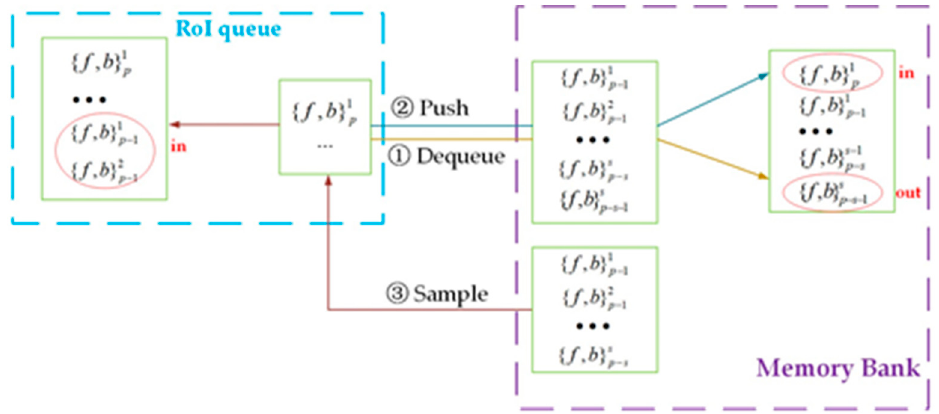
Figure 2. Dynamic object-centric memory bank operation.